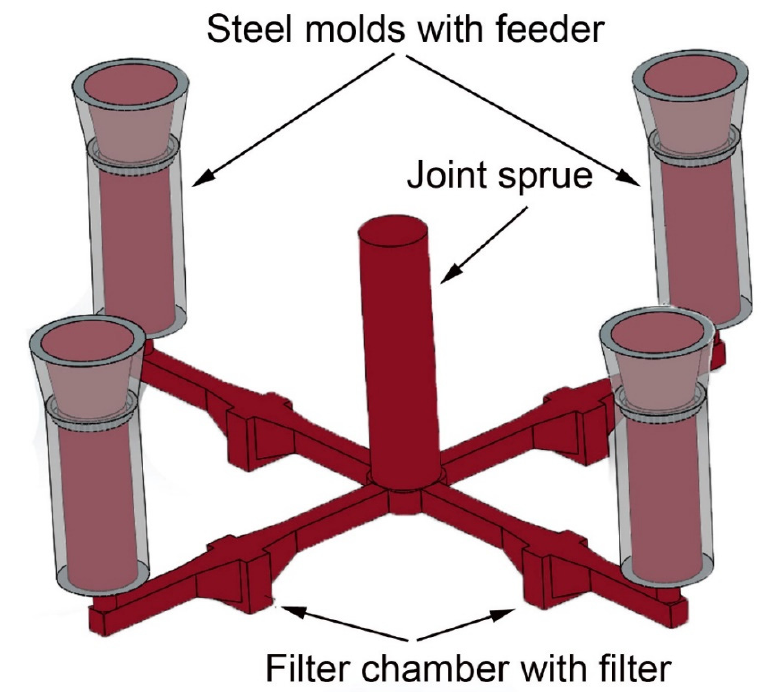
Figure 1. Casting system for the filtration trials with sand